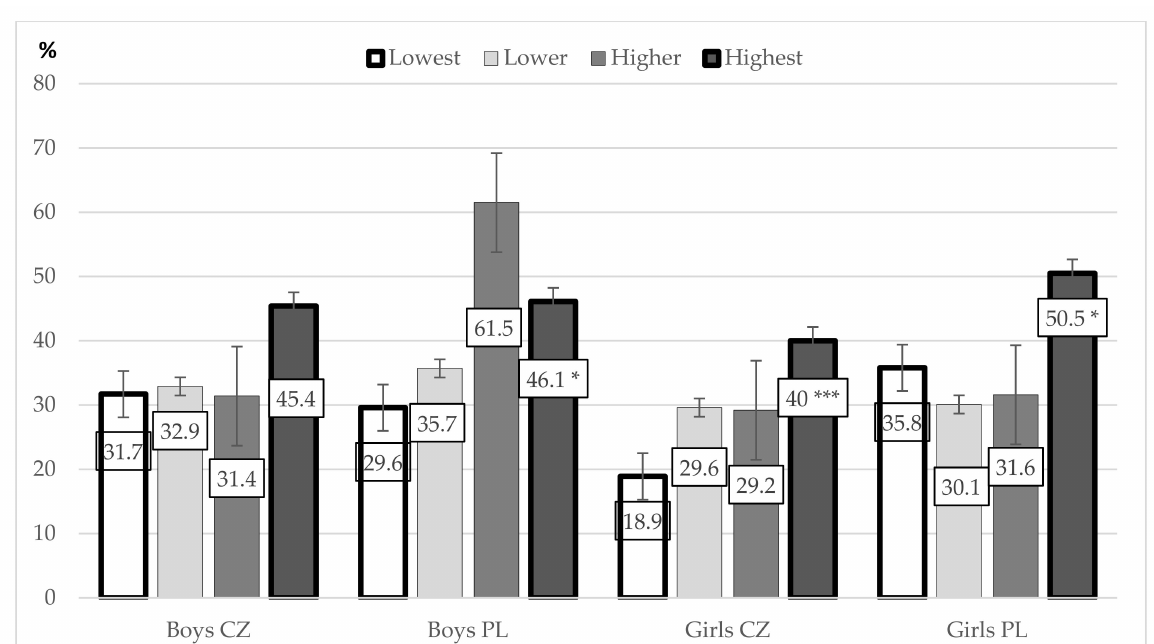
Figure 3. Associations between life satisfaction quartiles (lowest, lower, higher, highest) and the achievement (percentage of those achieving) of the recommendation for vigorous physical activity (VPA) (at least three periods of no less than 20 min of VPA per week) among Czech and Polish boys and girls. Significant difference between the groups with the lowest and highest LS: * p < 0.05; *** p < 0.001.